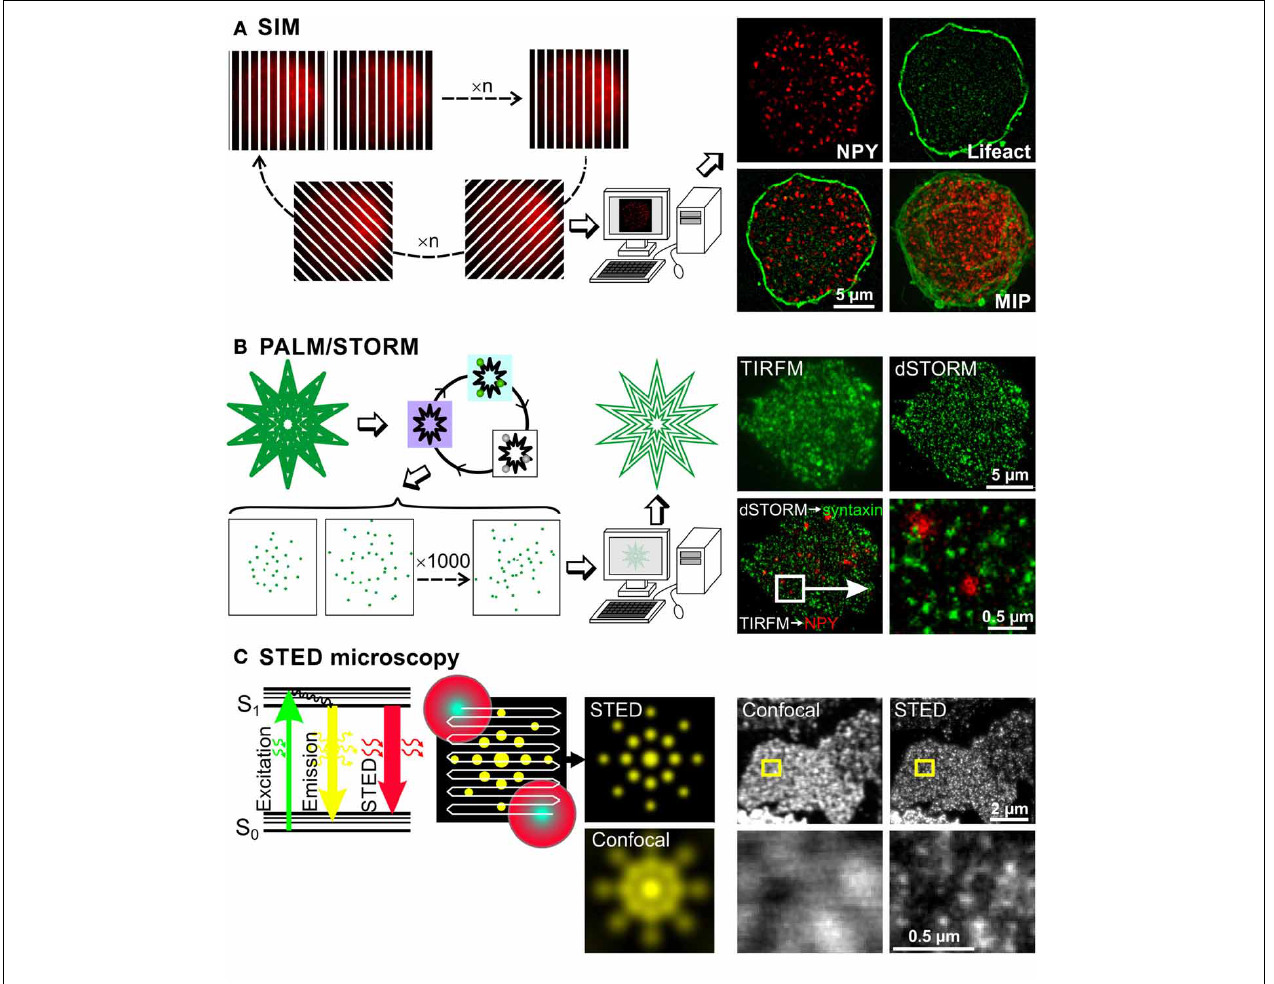
FIGURE 2 | Super-resolution microscopy methods to investigate chromaffin cell function. Basic principles of three super-resolution microscopy methods are depicted on the left, while some exemplary images using the respective technique are shown on the right. (A) In SIM microscopy a stripe pattern of light, which is shifted and rotated, is applied to the cell, so that the entire cell is illuminated within several images. These images contain sub-diffraction-limited structural information, which is extracted via computer processing using Fourier transformations. Resulting images have a lateral and axial resolution of 100 and 300nm, respectively. This can be appreciated on images of a bovine chromaffin cell, expressing NPY-mCherry and Lifeact-GFP labeling LDCVs and the F-actin, respectively. MIP: maximum intensity projection. (B) The principle of PALM and STORM exploit the properties of certain fluorophores that can be switched on and off. At first, all the fluorophores are pushed in a metastable dark state by illuminating them with their specific excitation light. Then, few molecules are brought back to the ground state using a mild illumination at usually 405nm and visualized using their excitation light, which switches them off again. These cycles are repeated up to 10,000 times generating a movie of blinking fluorophores. The labeled structure is then reconstituted by plotting their exact calculated position. This method generates images with lateral resolution of 10 to 30nm. This is shown on pictures of a bovine chromaffin cell. The LDCVs were marked by NPY-mCherry overexpression via Semliki Forest virus (shown in red) and the native syntaxin1 (shown in green) was labeled via monoclonal antibody (Synaptic Systems GmbH) and Alexa 647 anti-mouse secondary antibody (Invitrogen). The gain of resolution can